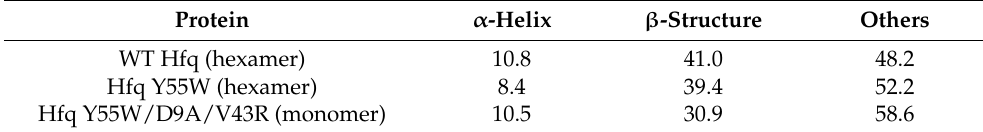
Table 1. The secondary structure content (%) of Hfq variants as shown by far-UV CD spectra deconvolution [30]. Protein α -Helix β -Structure